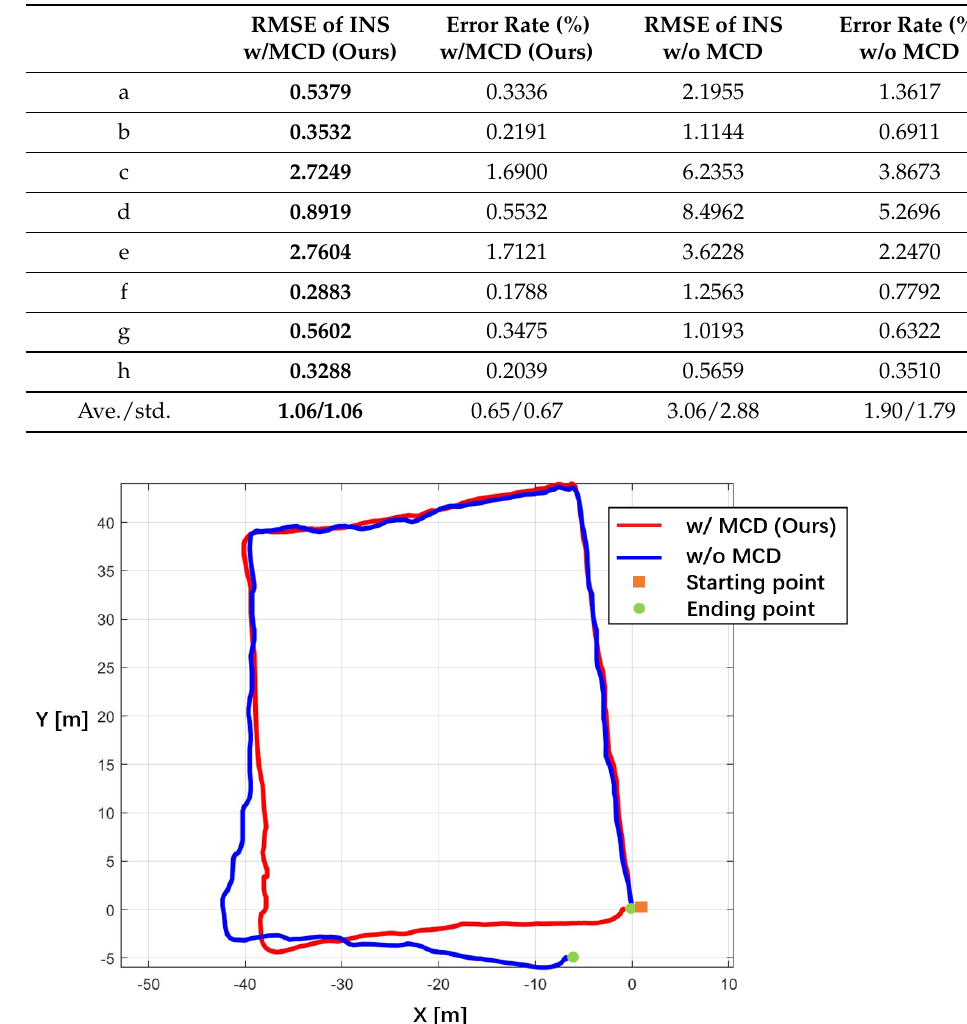
Table 4. Comparison of RMSE [M] of INS Trajectory with and without MCD Constraint for Scenario 1.